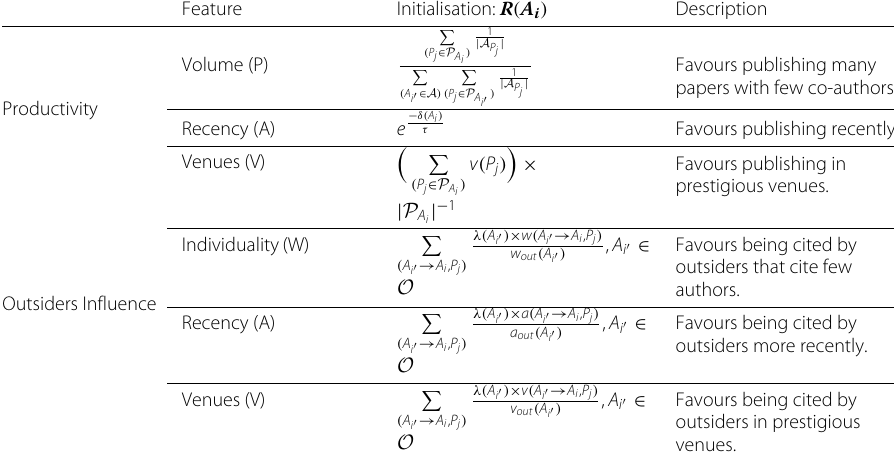
Table 3 List of features used for OTARIOS’ author rank initialisation: R ( A i